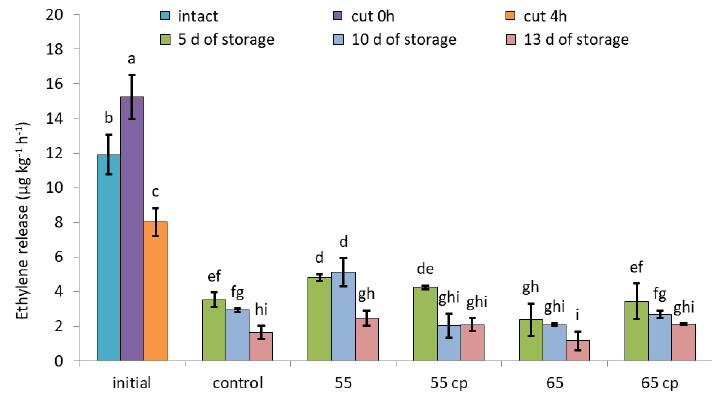
Figure 3. Ethylene release rates of short-term hot-water treated and untreated fresh-cut apple slices at days 5, 10 and 13 of storage in sugar syrup at 4 °C, compared to intact apples and untreated fresh- cut apple slices (initial). Given are means ± standard deviation ( n = 3). Different letters indicate significant differences between means ( p <